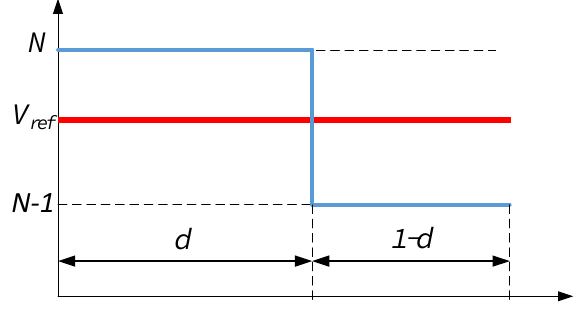
Figure 5. Operation principle of the NLM.